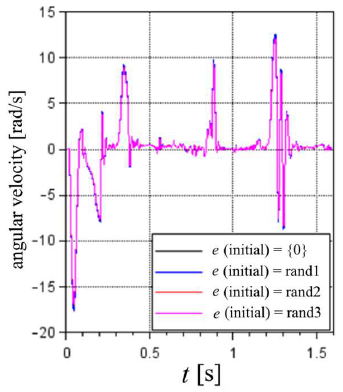
Figure 11. Angular velocity results considering different optimized e values. The first cycle of the 100% MS test.